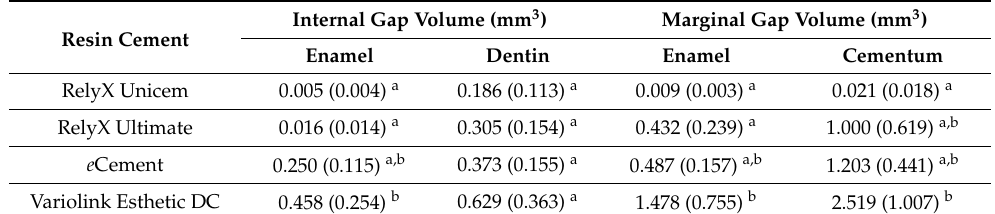
Table 3. Mean (SD) of internal and marginal gap volumes in mm 3 for different resin cements on enamel vs. cementum/dentin surfaces.